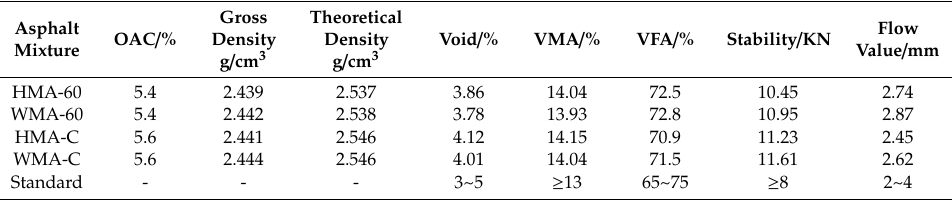
Table 3. Volume parameters of optimum asphalt